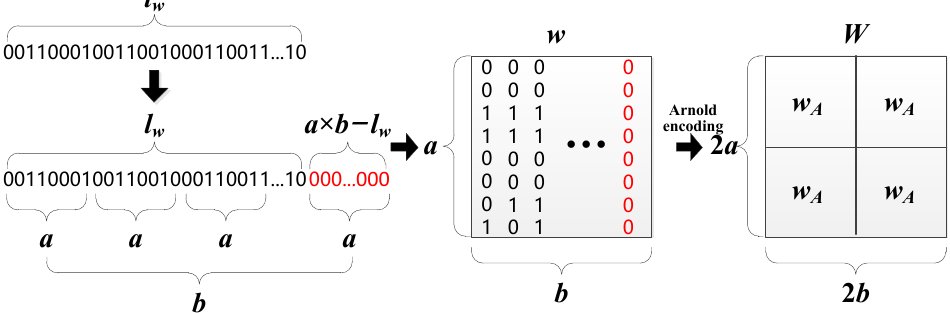
Figure 2. The main steps for generating a watermark matrix. Red color bits indicate the added bits.